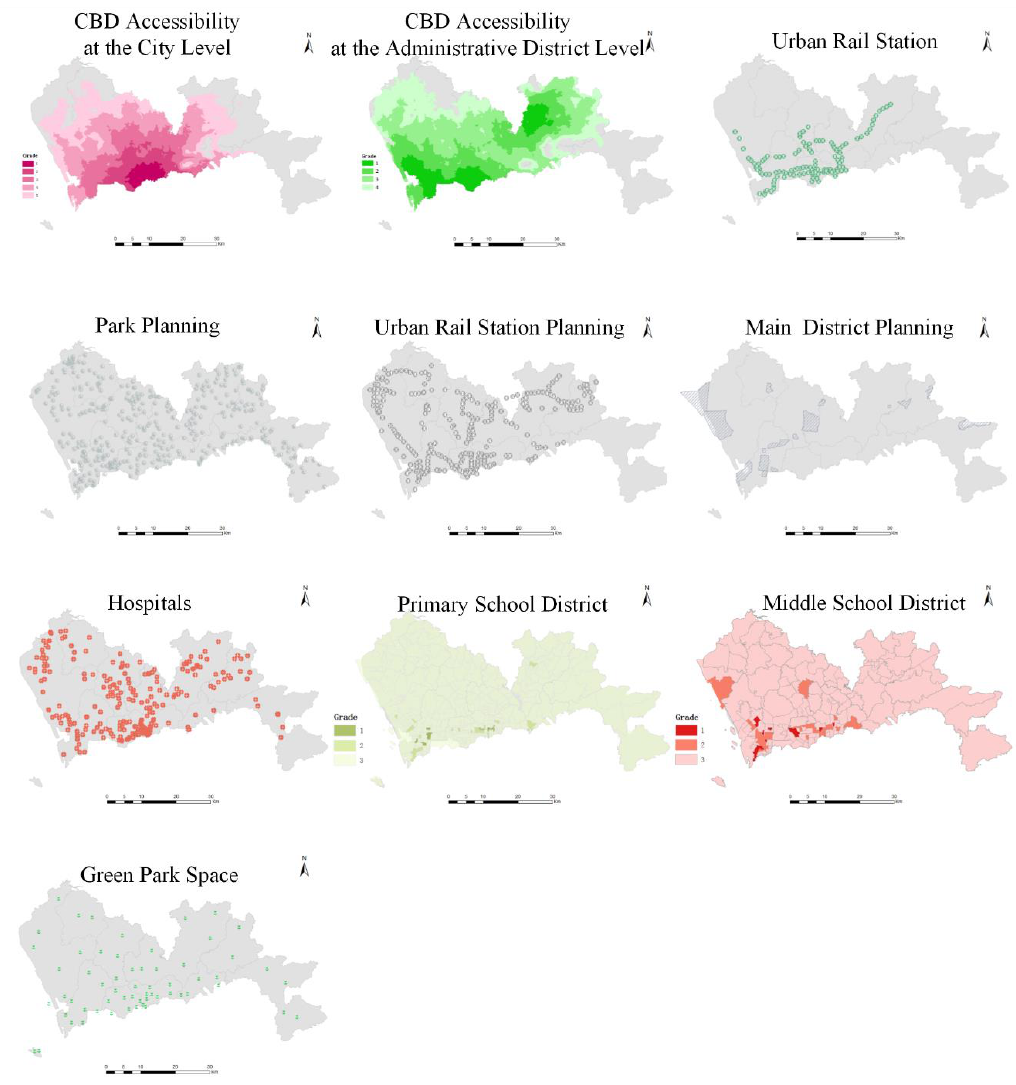
Figure 10. Layer services provided by the government.